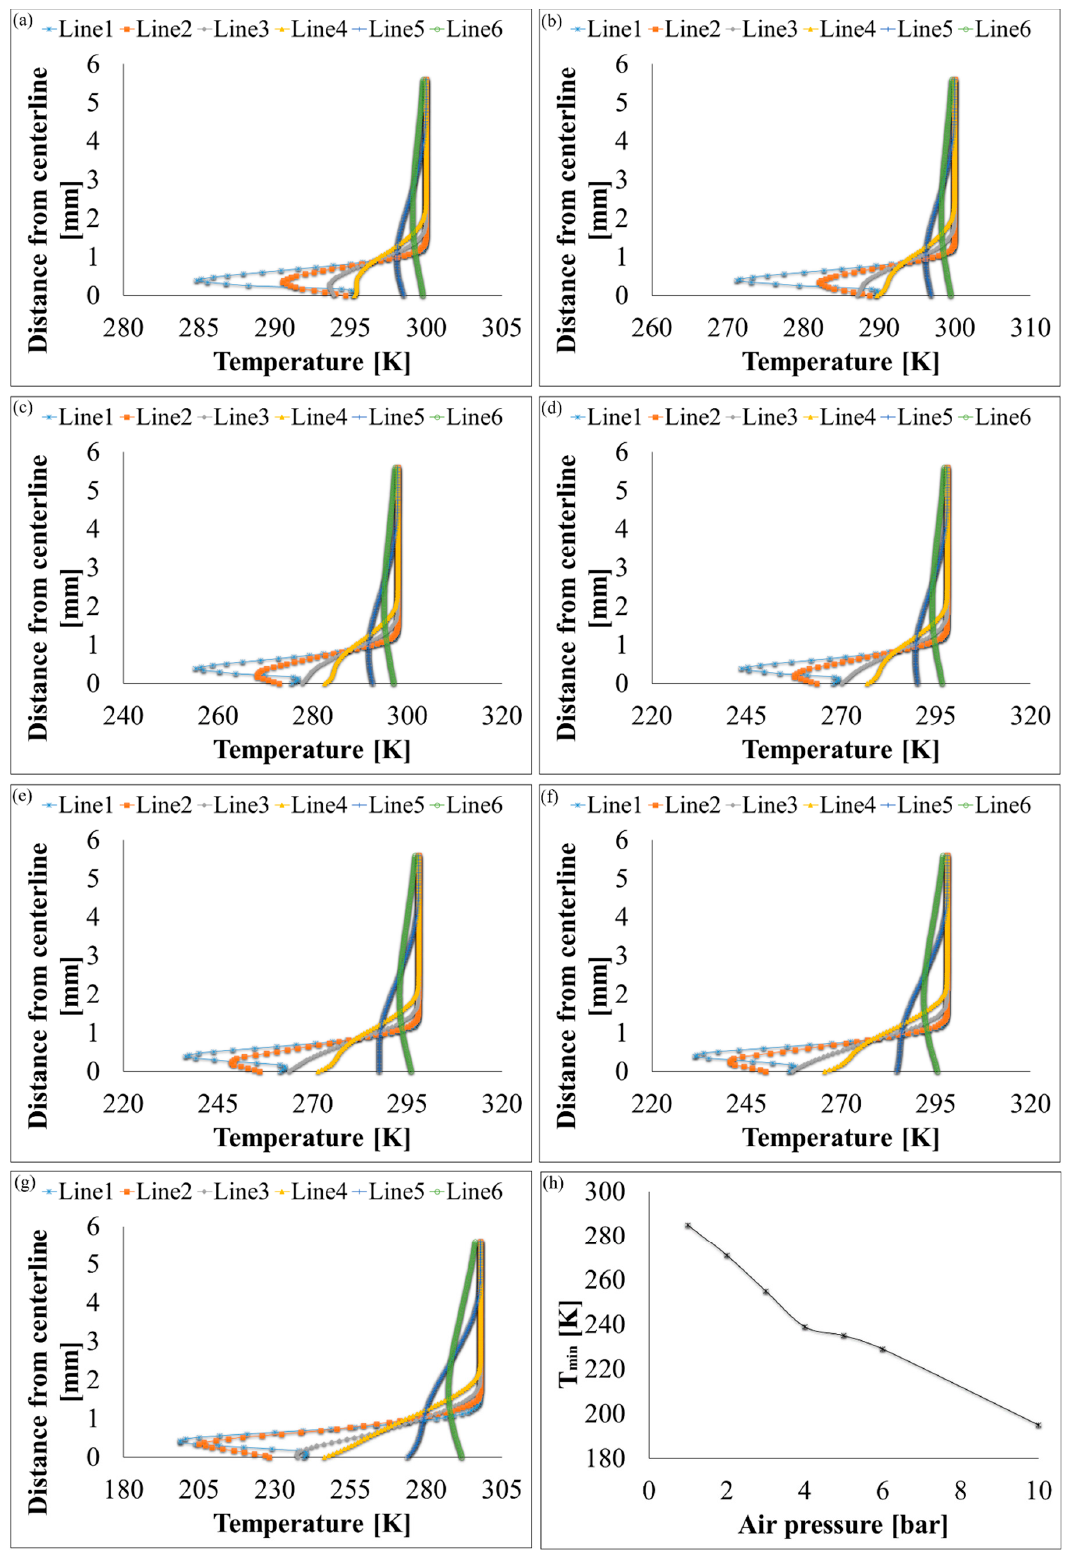
Figure 10. Temperature profiles at six vertical slices (at distance of 0, 1, 4, 6, 16, and 26 mm from the air outlet) for k- ε turbulence flow plots through SBS nozzle at different air pressures: ( a ) 1 bar, ( b ) 2 bar, ( c ) 3 bar, ( d ) 4 bar, ( e ) 5 bar, ( f ) 6 bar, ( g ) 10 bar, and ( h ) minimum temperature values at different air pressures.